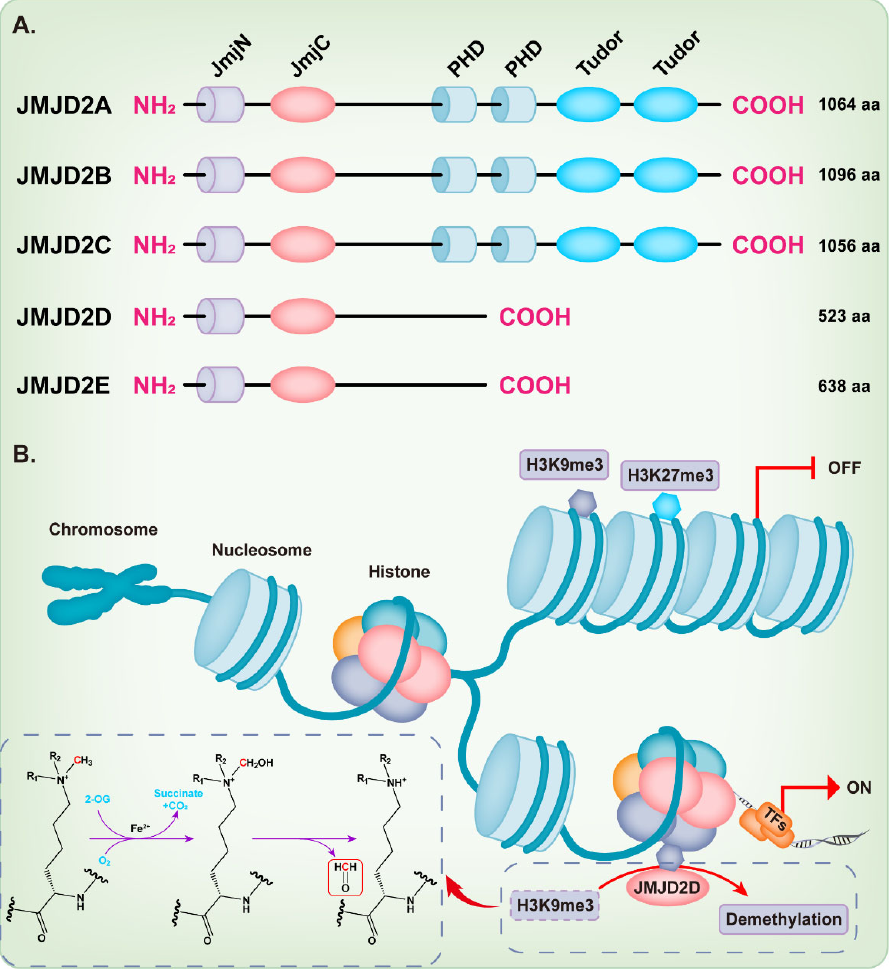
Figure 1. Structure and function of the JMJD2 histone demethylase subfamily. ( A ) The domain structure diagram of the JMJD2 histone demethylase subfamily. ( B ) JMJD2D facilitates a dioxygenase reaction requiring Fe 2+ , O 2 , and 2 ‐ oxoglutarate (2 ‐ OG) to demethylate H3K9me3.